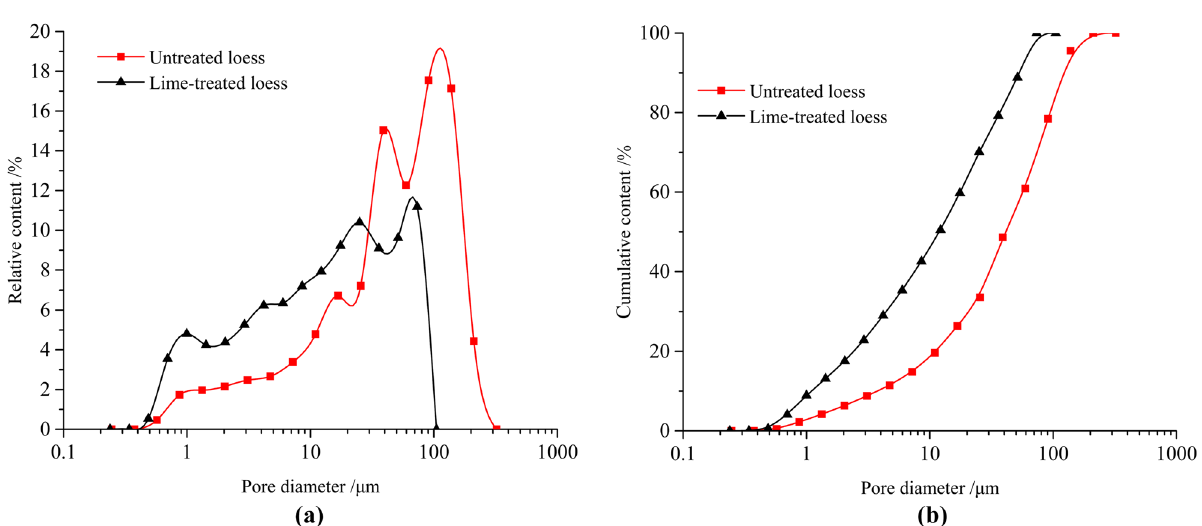
Figure 8. Pore distribution curve of untreated loess and lime-treated loess from Xining: ( a ) untreated loess; ( b ) lime-treated